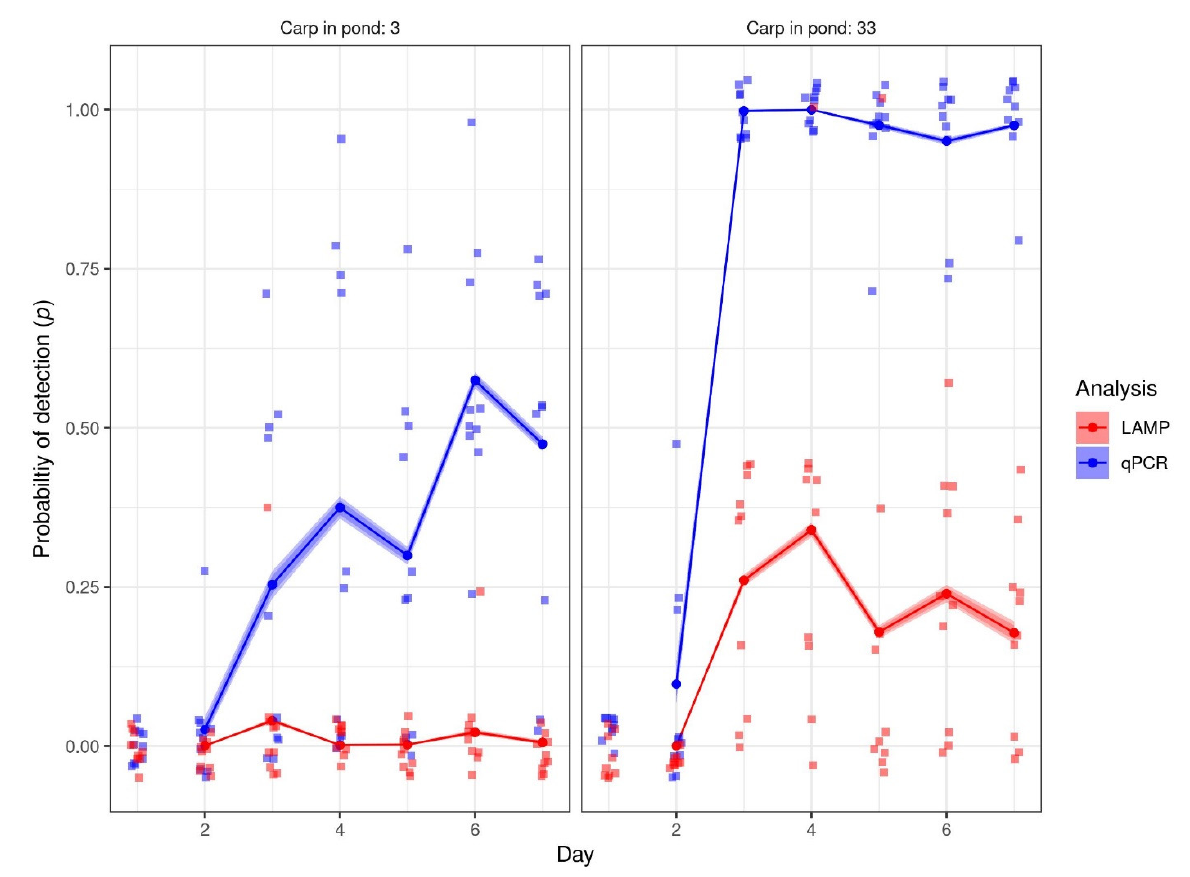
Figure 2. Probability of detection ( p ) grass carp eDNA by LAMP and qPCR over time. The probability of detection within an analytical replicate is modeled for each pond using occupancy modeling with 80% credible intervals shown in dark shading and 95% credible intervals shown in light shading. Square points represent the positivity rate for individual samples jittered around the observed values (0, 0.2, 0.4, 0.6, 0.8, or 1 for LAMP and 0, 0.25, 0.5, 0.75, or 1 for qPCR). The data are color coded by analytical method used: red = LAMP, blue = qPCR.